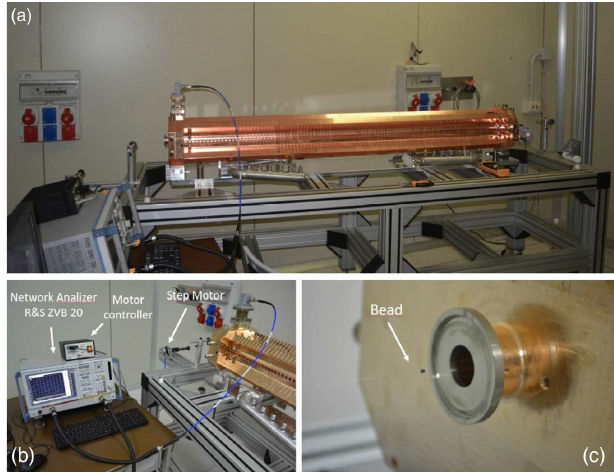
FIG. 10. Pictures of the structure under low-power rf tests and tuning: (a) cavity under test; (b) detail of the network analyzer and motor control; (c) metallic bead used for the field